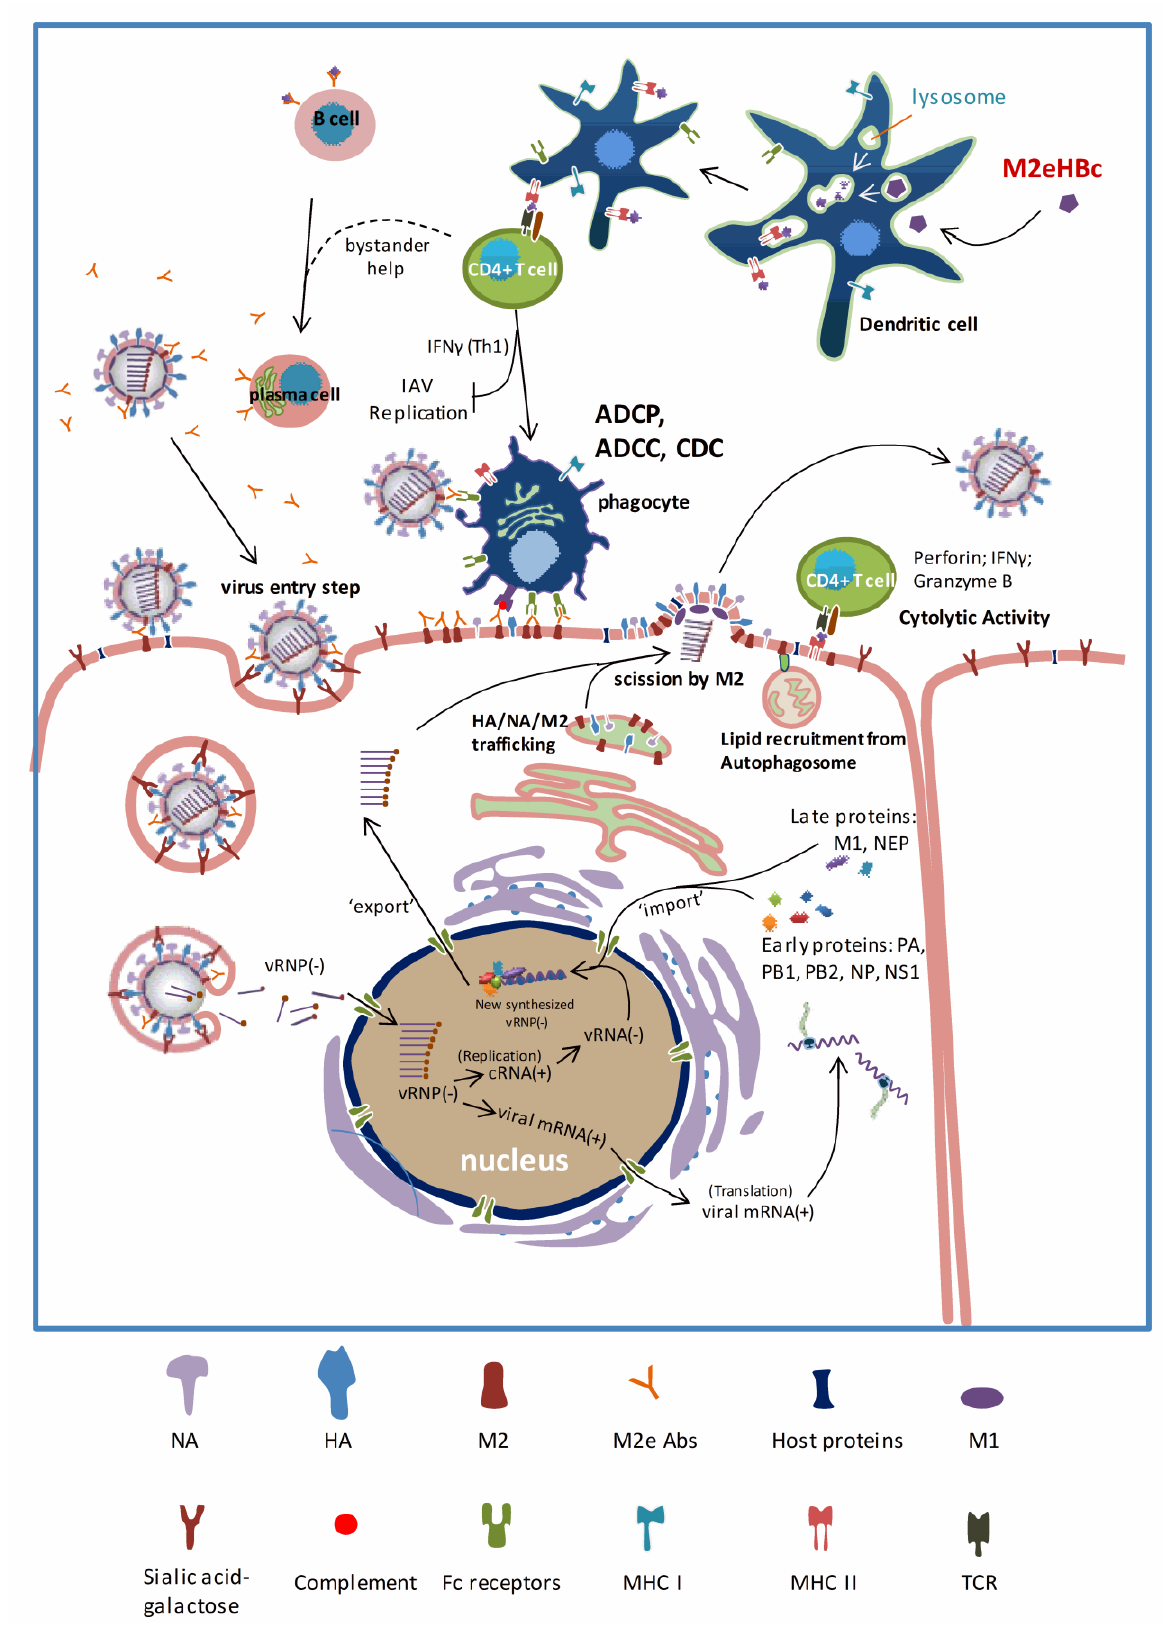
Figure 3. Influenza A virus infection cycle and mode of action of M2e based vaccines. The influenza A virions bind to sialic acid containing receptors on the surface of cells. Following endocytosis, the acidification of the endosome triggers the low-pH activation